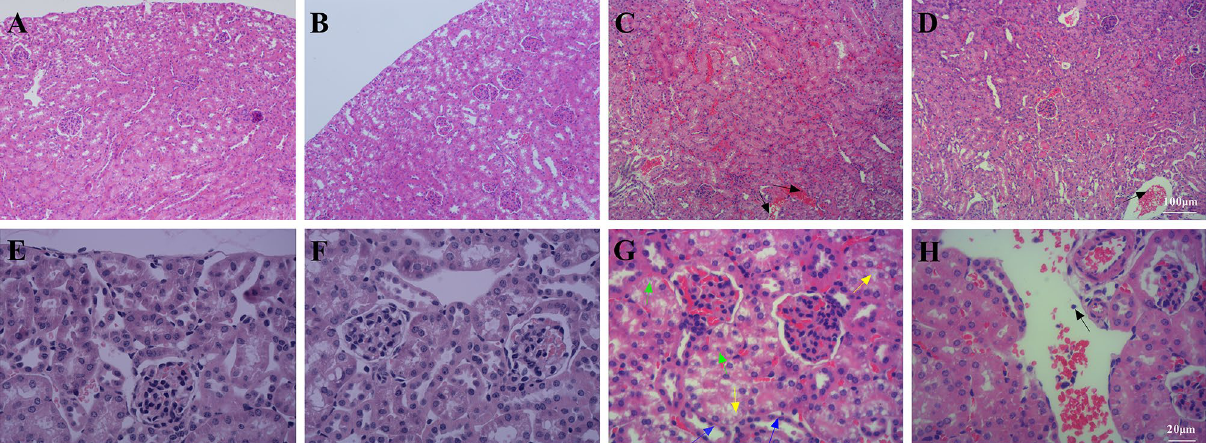
Figure 5. A photomicrograph of kidney tissues used for morphological analysis. ( A ) Con group, ( B ) LPS group, ( C ) Ex group, ( D ) Ex + LPS group. Black arrows indicate neutrophils. Yellow arrows indicate severe epithelial vacuolization. Blue arrows indicate flattening of the tubular epithelium. Green arrows indicate the appearance of an atypical shape with almost no nuclei [( A – D ) × 100 magnification; ( E – H ) × 400 magnification].